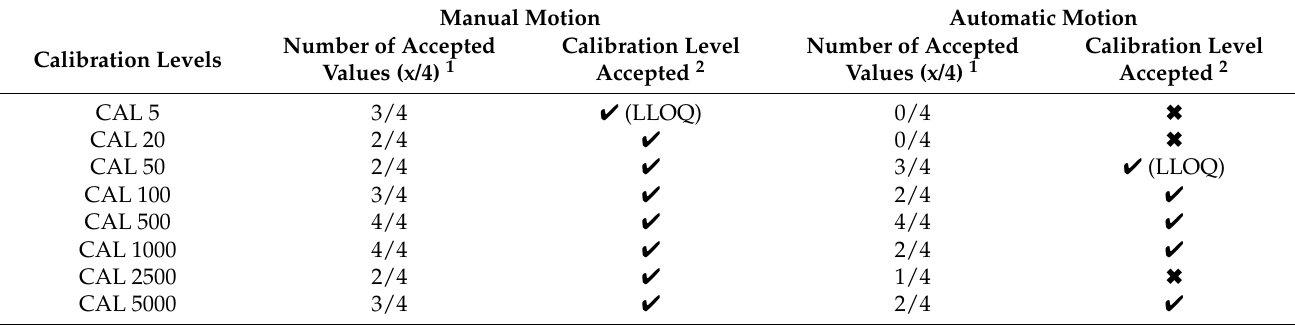
Table 2. Results for the construction of the calibration curves for the quantification of mebendazole (MBZ) in tissue sections using 2,5-dihydroxybenzoic acid (2,5-DHB) in MeOH/H 2 O/trifluoroacetic acid (TFA) 50:50:0.1 ( v / v / v ) with manual or automatic